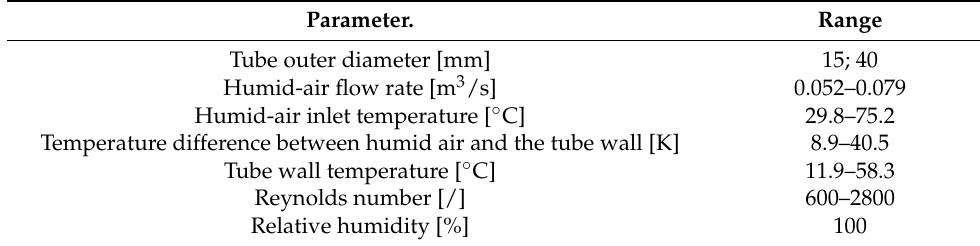
Table 4. Range of process parameters valid for the new, semi-empirical correlation Equation